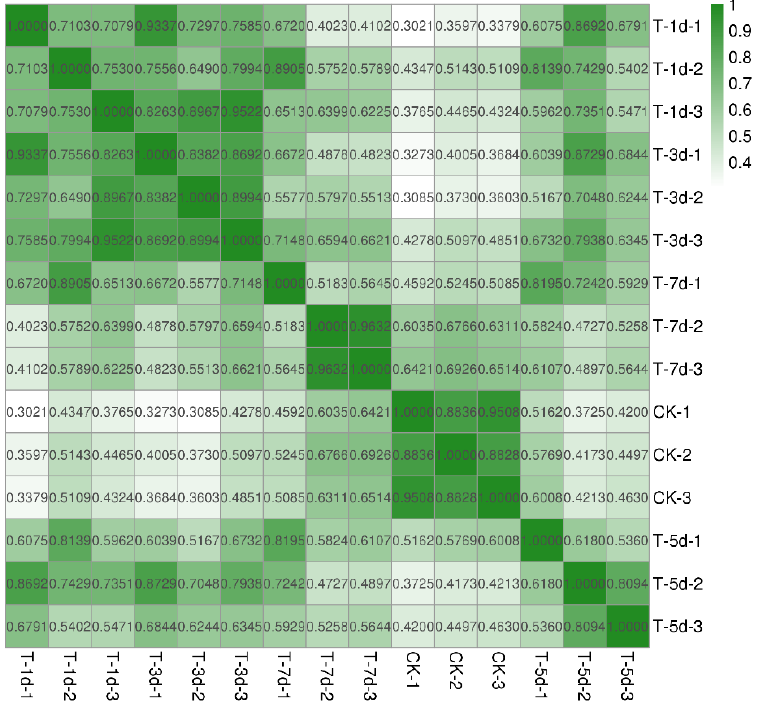
Figure 2. Heat map of differentially expressed genes between different samples; the horizontal and